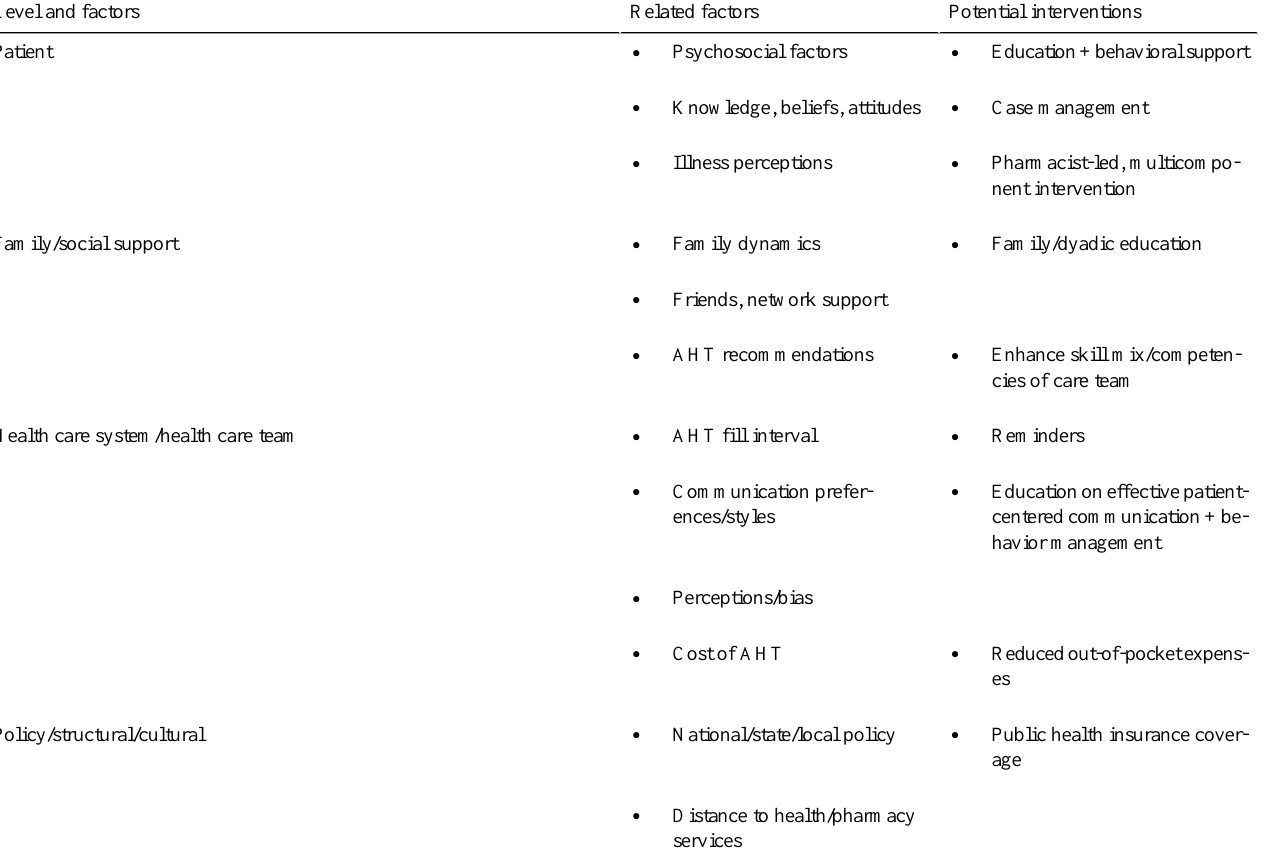
Table 1. Modifiable factors at multiple levels that influence adherence to adjuvant hormonal therapy [27-29].